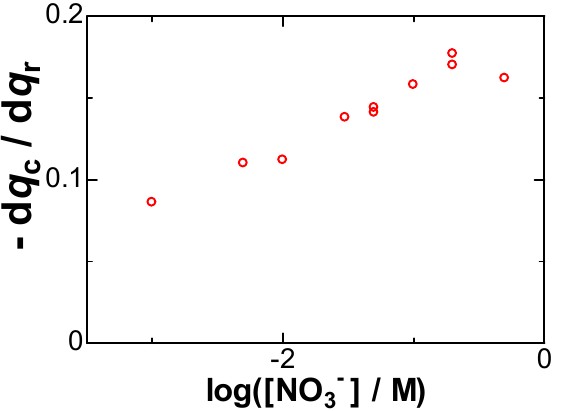
Figure 5. Dependence of the slope of the plot of q c vs. q r on log([NO 3− ]/M) obtained in 0.05 mM AgNO 3 .